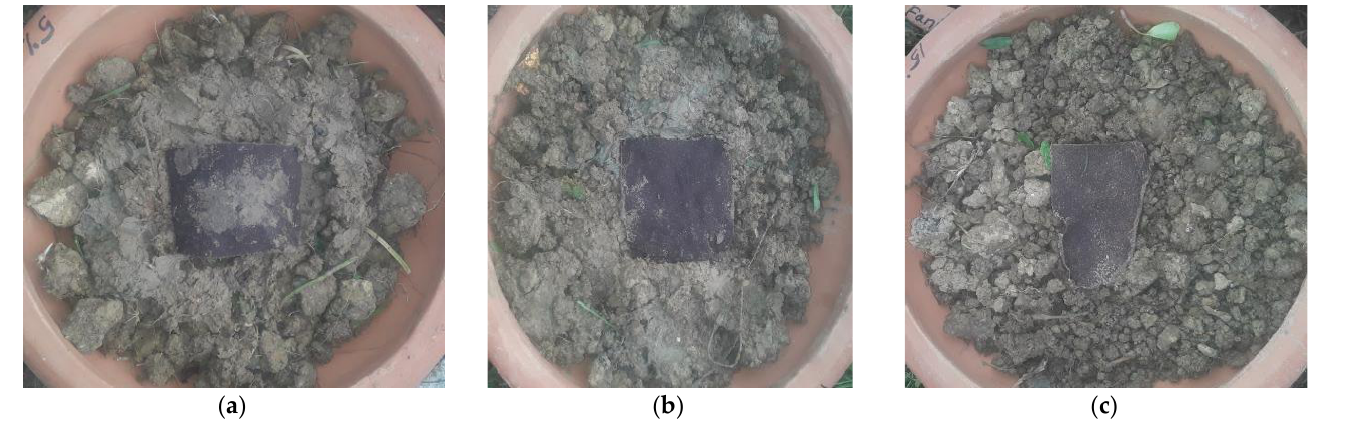
Figure 2. Prepared samples for soil biodegradation test ( a ) 5% fenugreek, ( b ) 10% fenugreek, and ( c ) 15% fenugreek.